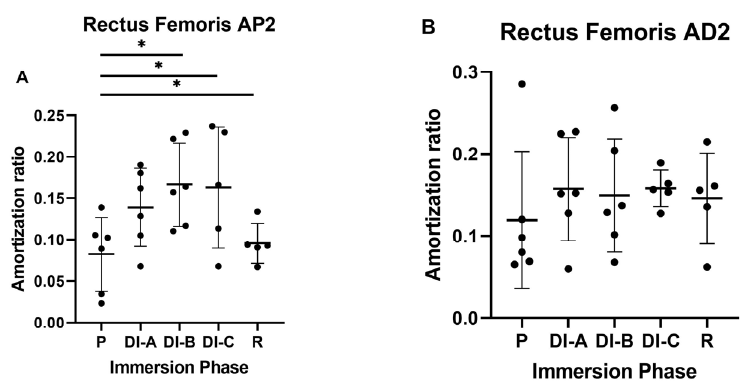
Figure 6. Amortization ratio for rectus femoris muscle (RF): ( A ) far proximal propagation (P2) and ( B ) far distal propagation (D2). The statistical significance of results is noted with an asterisk (*): * p < 0.05.